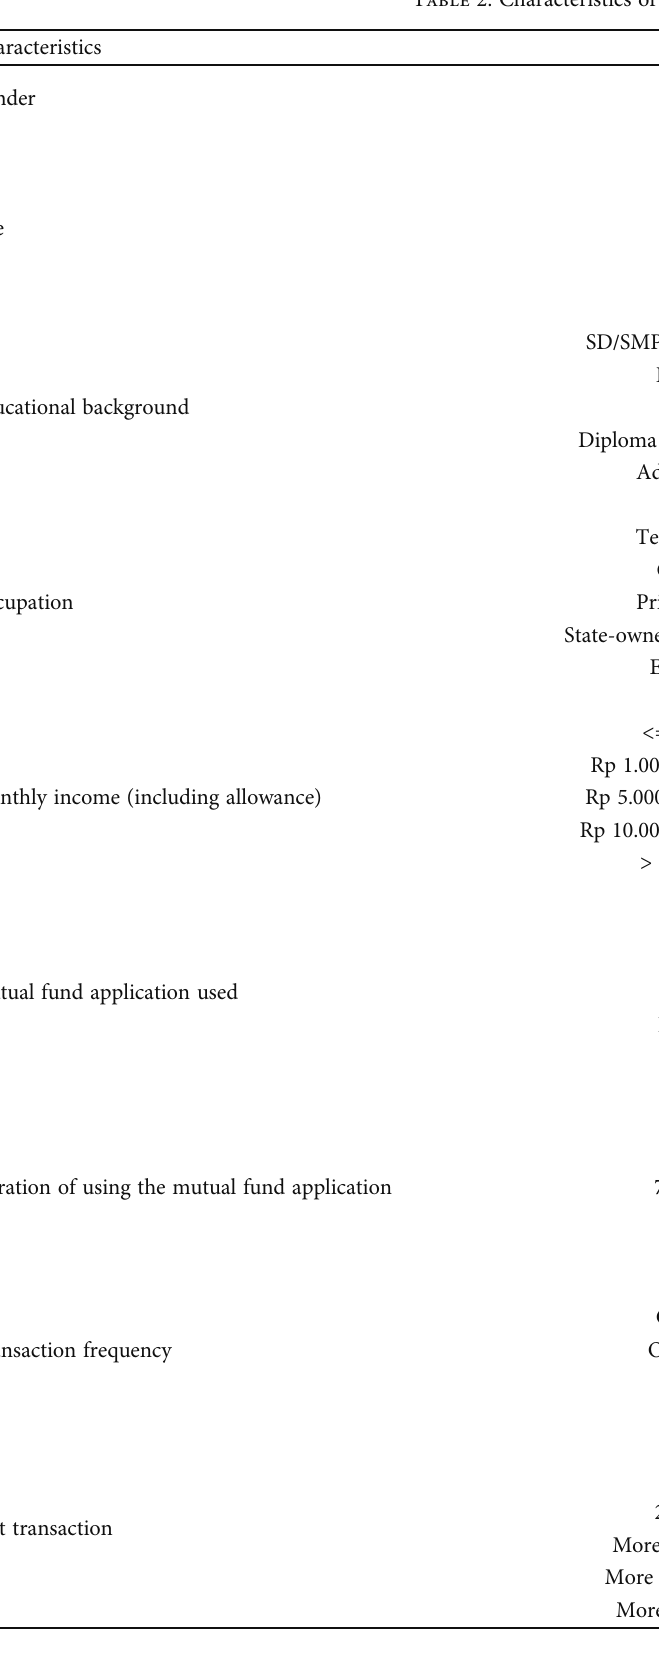
Table 2: Characteristics of the